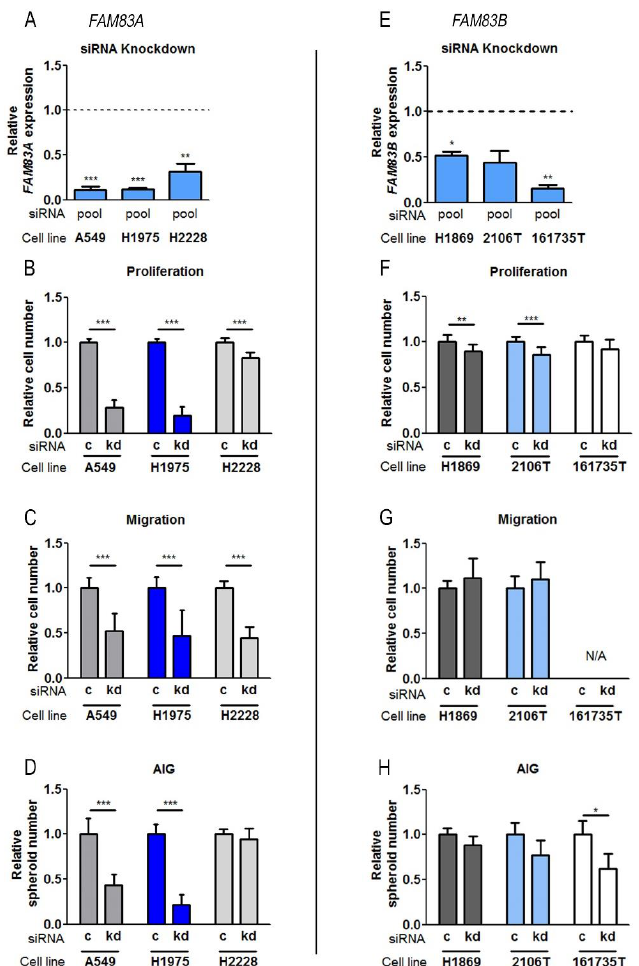
Figure 4. Investigation of the role of FAM83A and B in NSCLC cell lines. ( A ) FAM83A depletion efficiency. ( B – D ) Effect of decreased gene expression in ADC cell lines on ( B ) proliferation, ( C ) migration, and ( D ) ability of anchorage-independent growth (AIG). Relative cell or spheroid number of cells after FAM83A knockdown (kd) compared to control (c). ( E – H ) Corresponding results for FAM83B . At